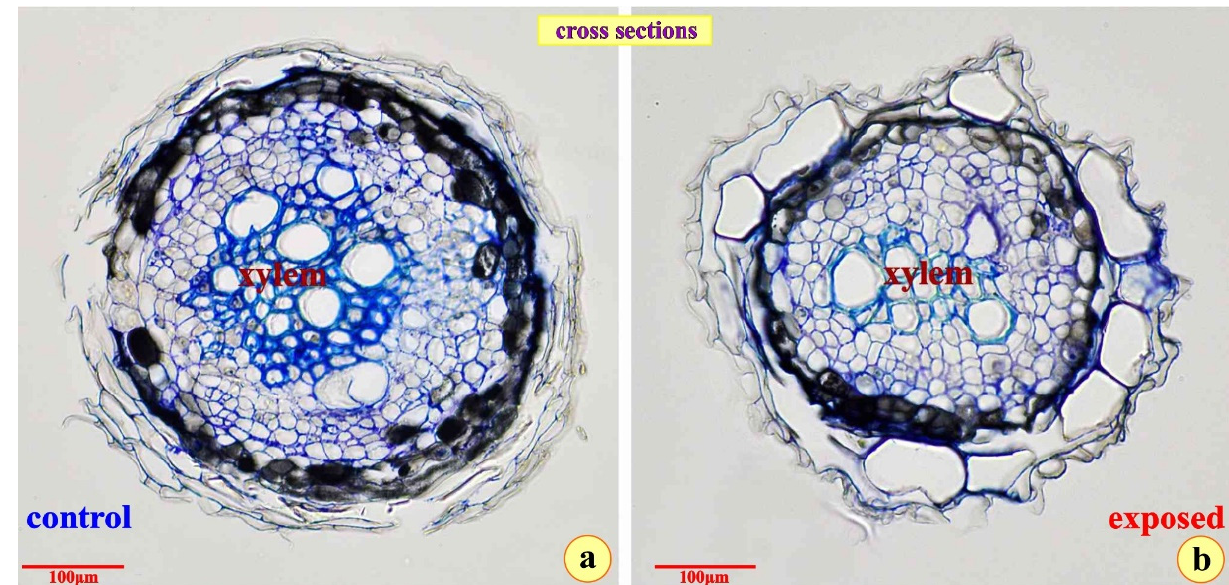
Figure 10. Cross-sections of the roots at 2 mm above the root tip. ( a ) The root of the “control” plant. The developed xylem can easily be observed. ( b ) The root of an “exposed” plant. The xylem is hardly developed, while many conductive elements still possess non-lignified walls. In both sections, the layer of tannin-containing cells, surrounding the central cylinder, can easily be distinguished. (All scale bars are 100 μ m)